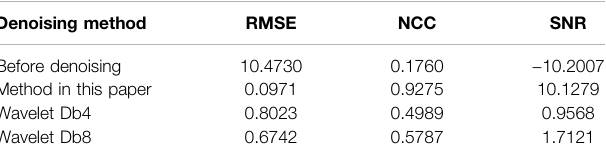
TABLE 3 | Evaluation indexes of denoising effect of measured nuclear signals in the laboratory. Denoising method RMSE NCC SNR Before denoising 10.4730 Method in this